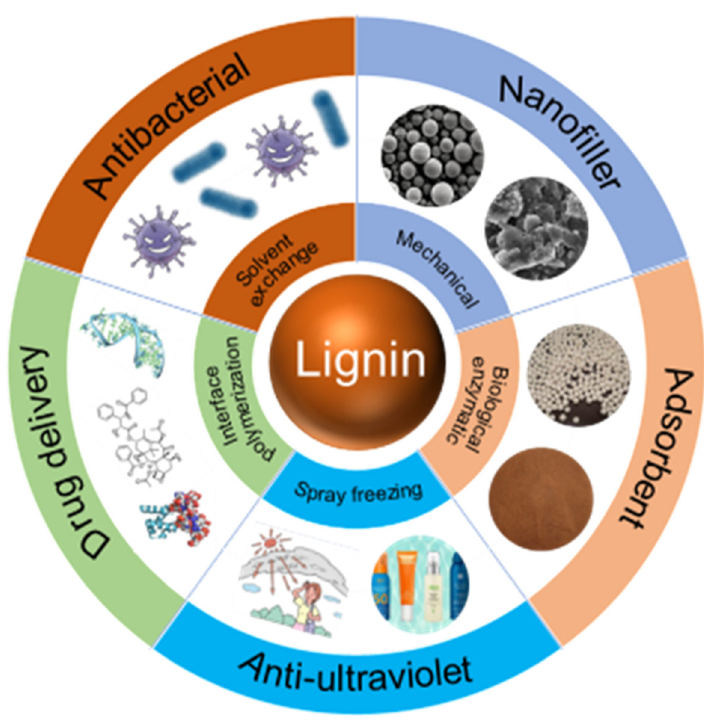
Figure 1. Preparation methods and application of lignin nanoparticles.